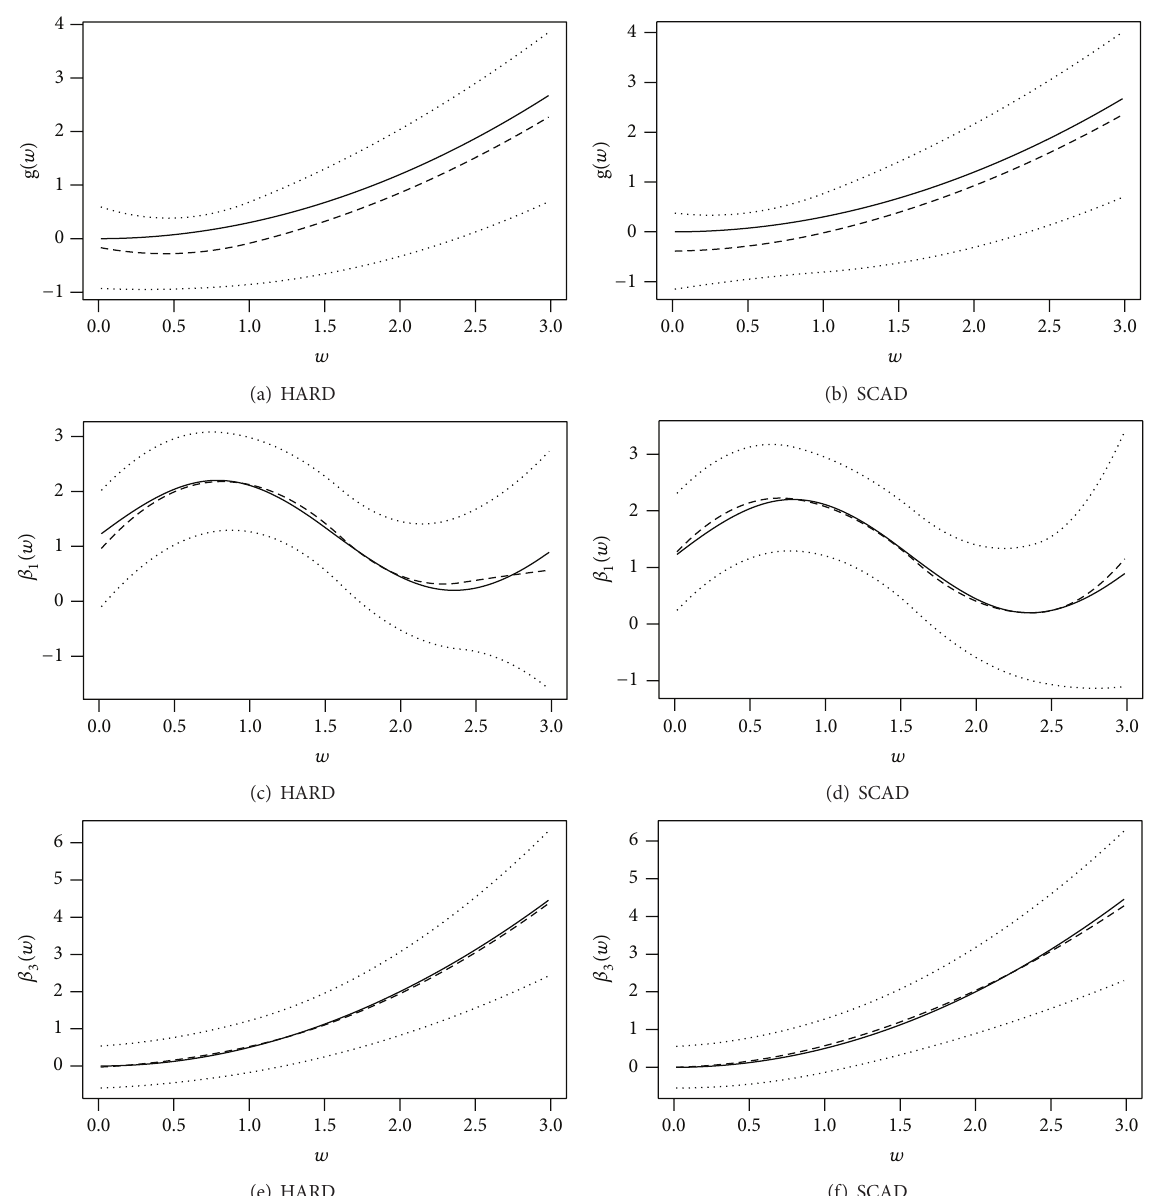
Figure 1: Results of the simulation study for scenario (I): the estimated curves of the nonzero functional coefficients 𝛽 1 (𝑤) , 𝛽 3 (𝑤) , and 𝑔(𝑤) . The solid, dashed, and dotted curves represent the true function, estimated functions, and 95% pointwise confidence intervals, respectively. Left panel—HARD penalty; right panel—SCAD